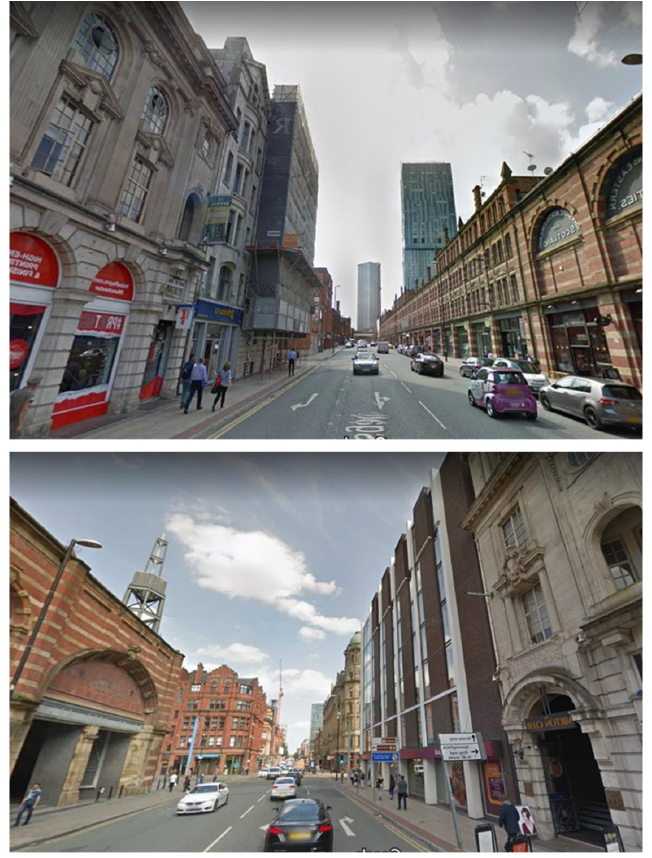
Figure 2. VR-urban exposure, front and back perspectives.